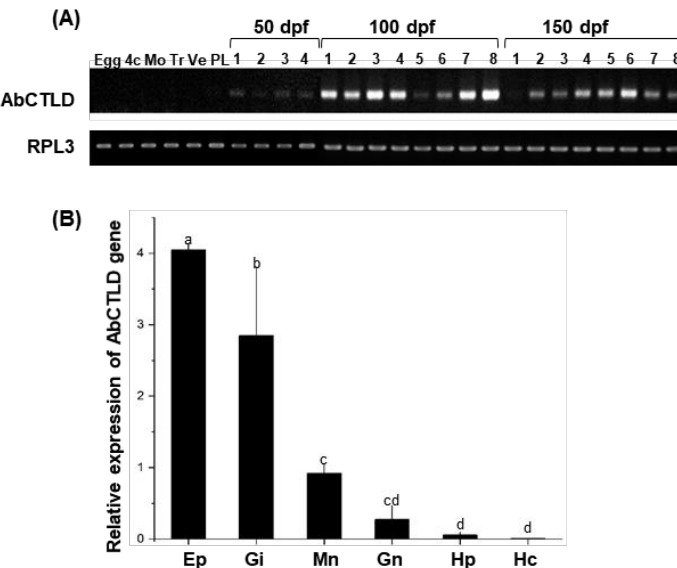
Figure 4. AbCTLD expression analysis of distinct developmental stages and tissues in Pacific abalone. ( A ) Reverse transcription (RT)-polymerase chain reaction (PCR)-based detection of AbCTLD expression throughout abalone development. The early stages of development included unfertilized eggs (Egg), the four-cell stage (4c), and the morula (Mo), trochophore (Tr), veliger (Ve), and post-larval stages (PL, meaning 5 days post-fertilization (dpf)), as well as juvenile abalone spat at 50 ( n = 4), 100 ( n = 8), and 150 ( n = 8) dpf. ( B ) Tissue-specific abundances of AbCTLD mRNA transcripts in Pacific abalone were also analyzed by quantitative real-time-PCR using cDNA from total RNA samples that had been isolated from various tissues (e.g., epipodium (Ep), gill (Gi), mantle (Mn), gonads (Gn), hepatopancreas (Hp), and hepatocytes (Hc)) in 2-year-old Pacific abalone ( n = 5). Bars and error bars represent the means and standard deviations of triplicate measurements. Different letters above each bar indicate statistically significant difference ( p <